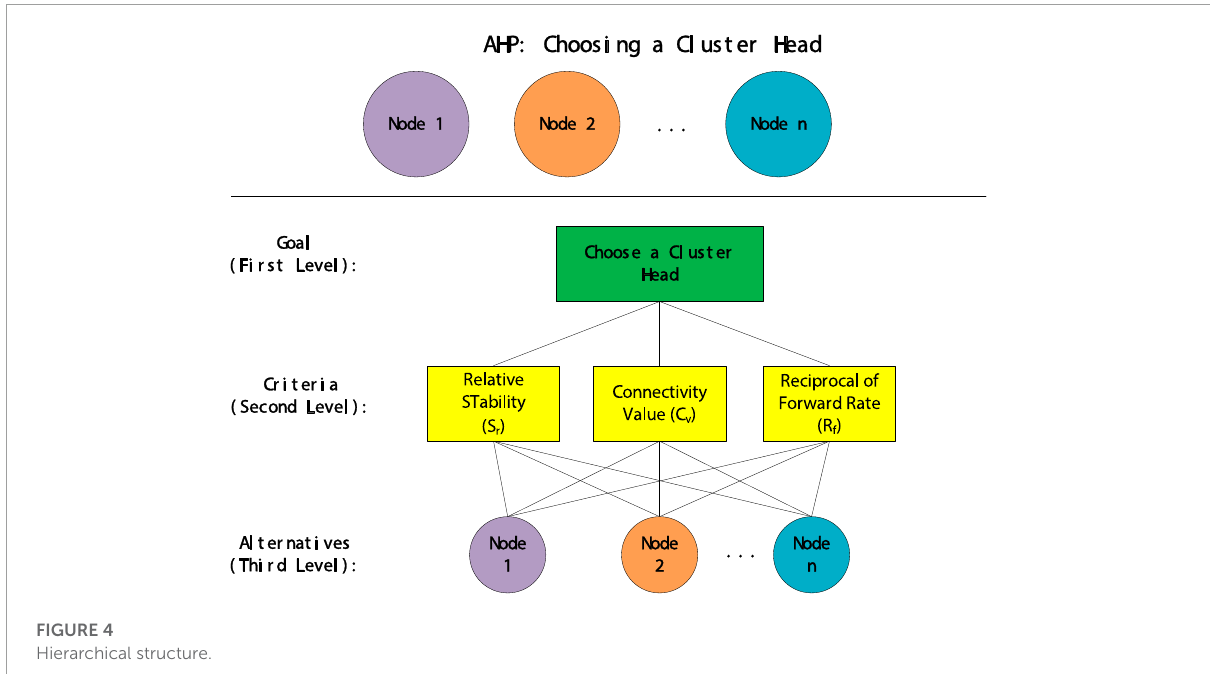
FIGURE 4 Hierarchical